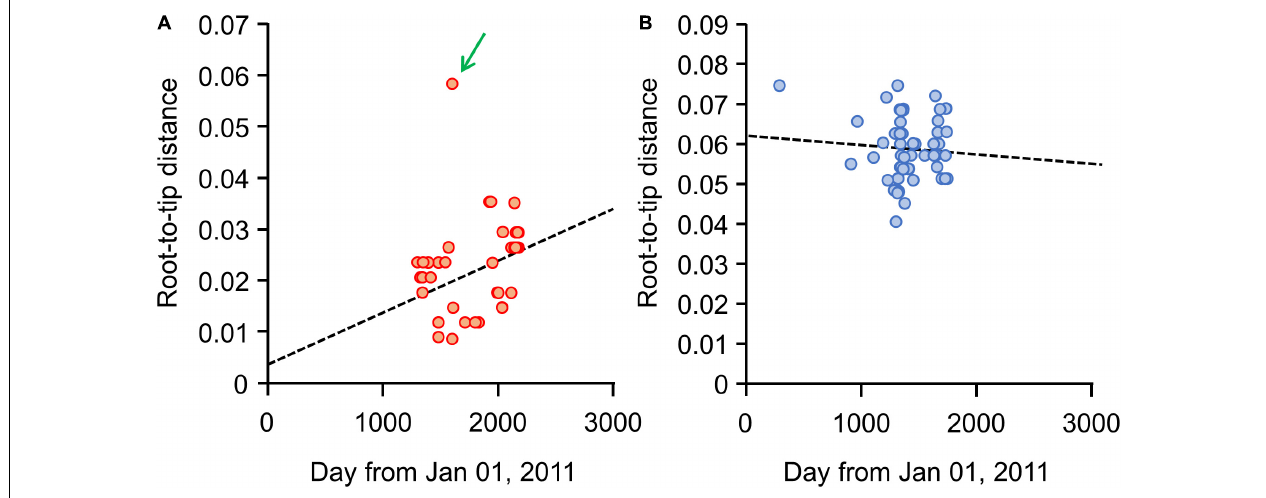
FIGURE 3 | Root-to-tip analysis for each S . Chester isolated in the Kanto region of Japan or Europe. The X-axis represents the isolation date of each S . Chester isolate as the days lapsed from January 01, 2011. The Y-axis represents the genetic distance to each isolate from the root in the dendrogram for isolates from (A) the Kanto region or (B) from Europe. Dotted lines represent the regression lines drawn from (A) the Kanto region’s isolates, excluding isolate 29149, and (B) the European isolates. A green arrow indicates isolate